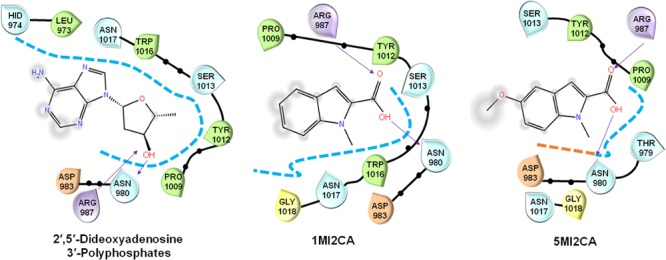
Molecular docking of the interaction between 1MI2CA or 5MI2CA and adenylate cyclase. The binding orientations of 1MI2CA and 5MI2CA within the active site of adenylate cyclase were similar to that of 2′,5′-dideoxyadenosine 3′-polyphosphate as a positive control.